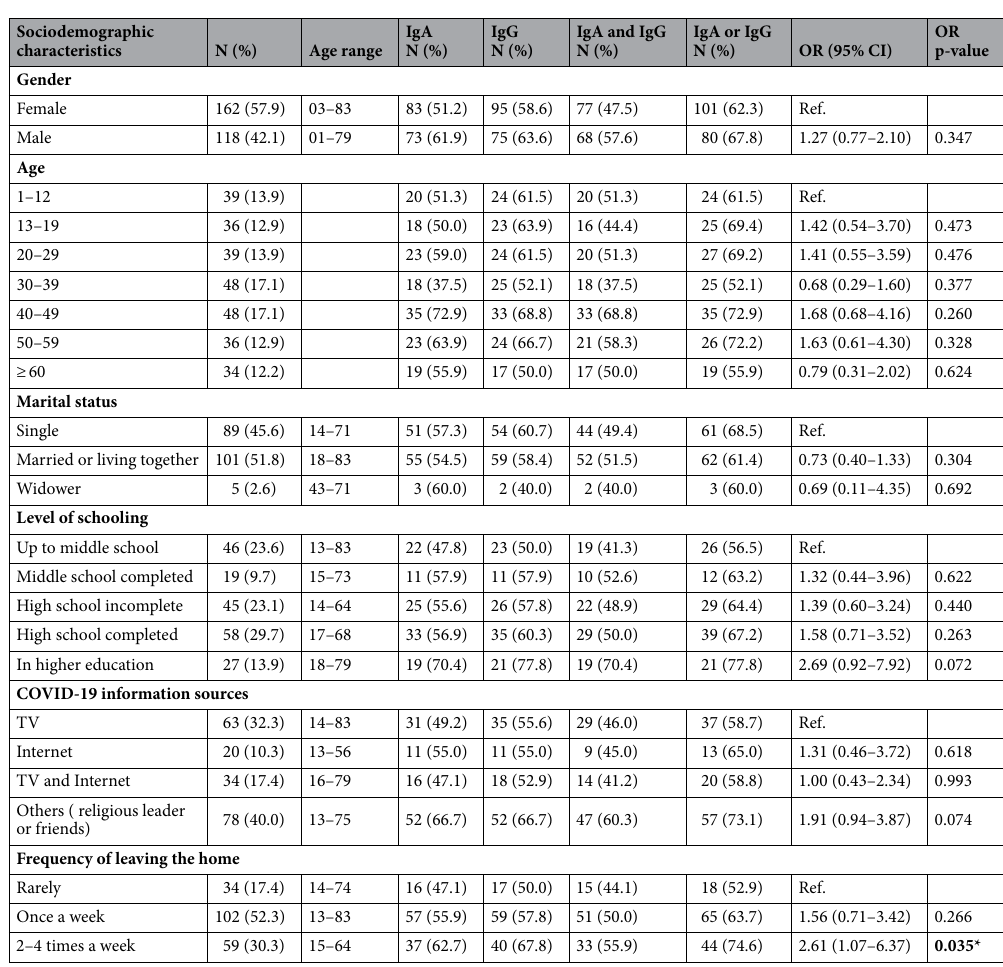
Table 1. SARS-CoV-2 positivity according to sociodemographic characteristics of the study population. OR Odds Ratio obtained through multivariate analysis using logistic regression, CI Confidence Interval. p < 0.05